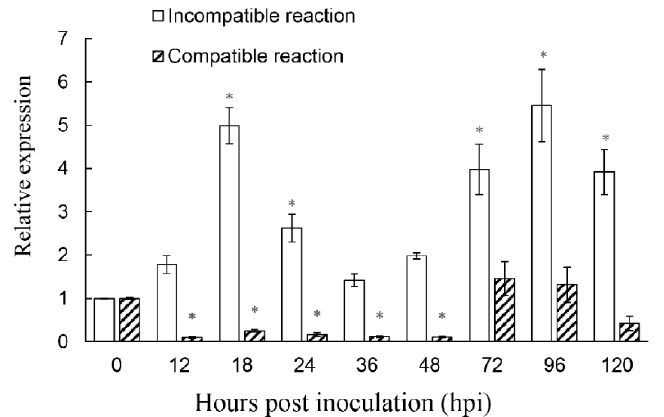
Figure 3. The accumulation of ShROP7 mRNA is differentially induced in tomato leaves following inoculation with Oidium neolycopersici -LZ ( On -LZ). Error bars represent the variation from three inde- pendent replicates. The asterisk ( * ) indicates a significant difference between inoculation timepoints and 0 hpi ( P < 0.05).